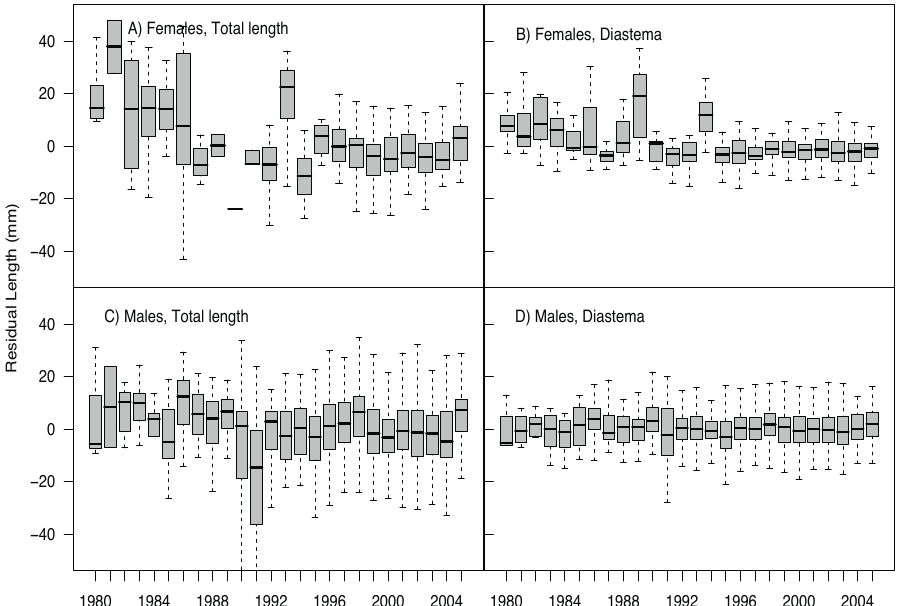
Fig. 4. Trends in jawbone size for males and females in the Middle Ridge herd, 1980-2005, based on re- siduals from Gompertz growth equations. The boxes contain the 25th to 75th percentiles of the data and the horizontal line indicates the median. The whiskers extend to 1.5 times the inter-quartile range.